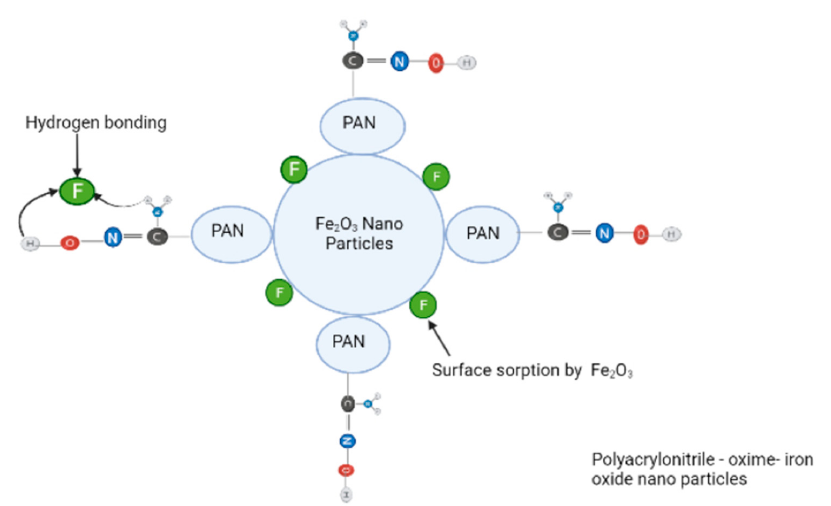
Figure 14. Adsorption mechanism of fluoride ions by polyacrylonitrile-oxime-iron oxide nano-particles.